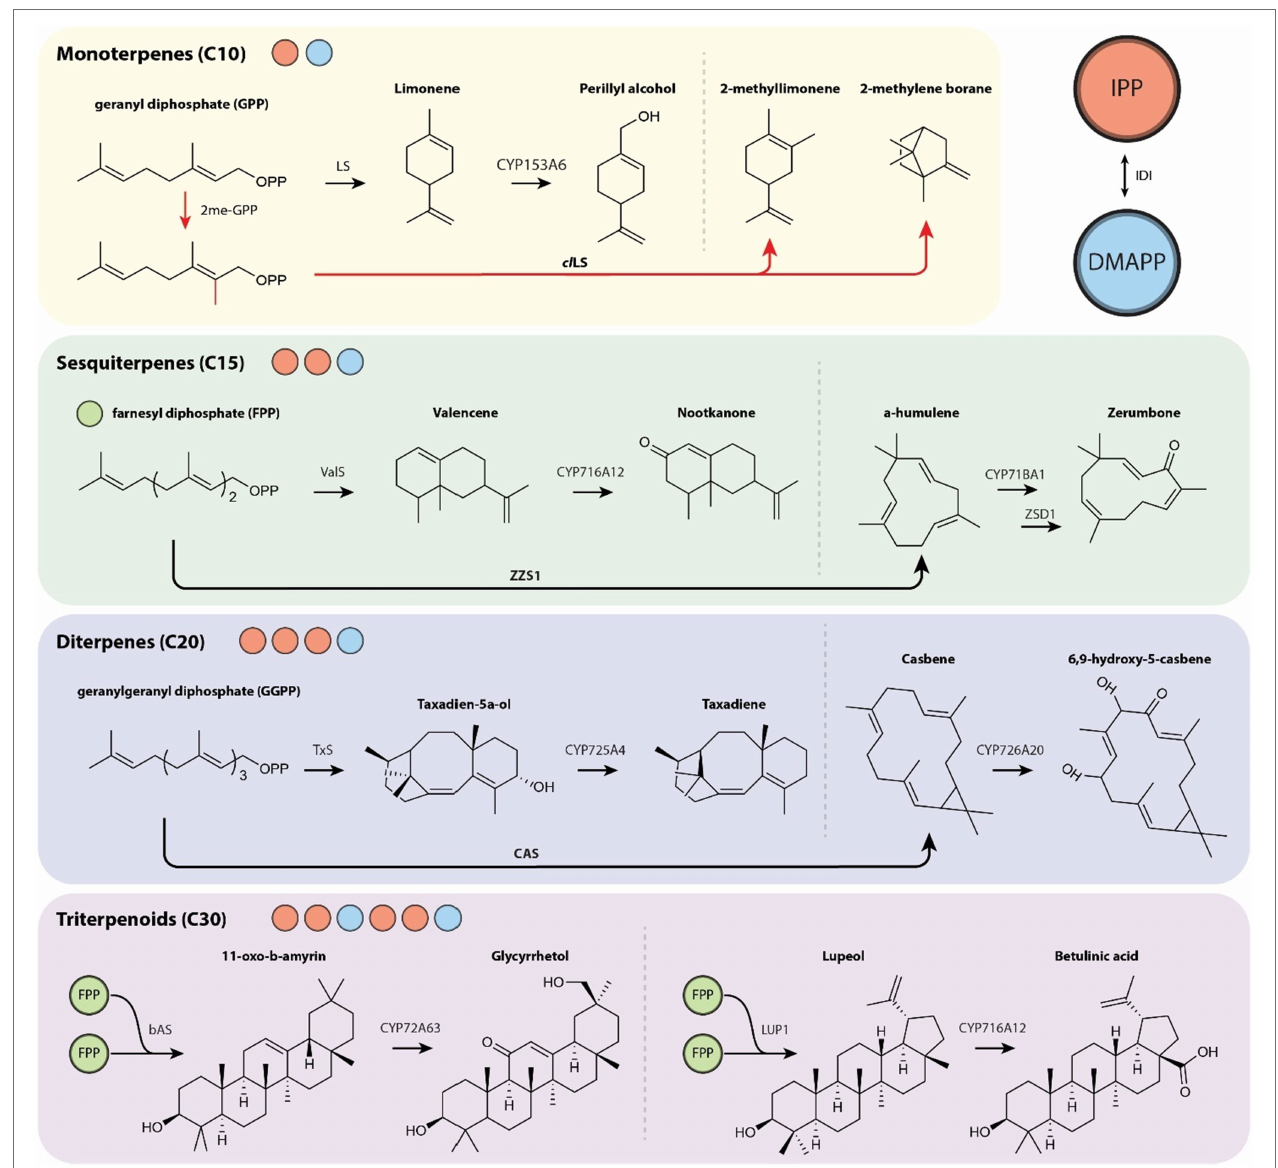
FIGURE 2 | Overview of varied length terpenoids from their diphosphate precursors (red circle, IPP; blue circle, DMAPP; green circle, FPP) with further modification by TSs and subsequent decoration by CYPs. The production of unnatural C11 monoterpenoid compounds via methyltransferase 2me-GPP is indicated with red arrows. CAS, casbene synthase; LS, limonene synthase; cl LS, Citrus limon limonene synthase; 2me-GPP, GPP methyltransferase; TxS, taxadiene synthase; bAS, β -amyrin synthase; LUP1, lupeol synthase 1; ValS, valencene synthase; ZSD1, zerumbone synthase; ZZS1, α -humulene